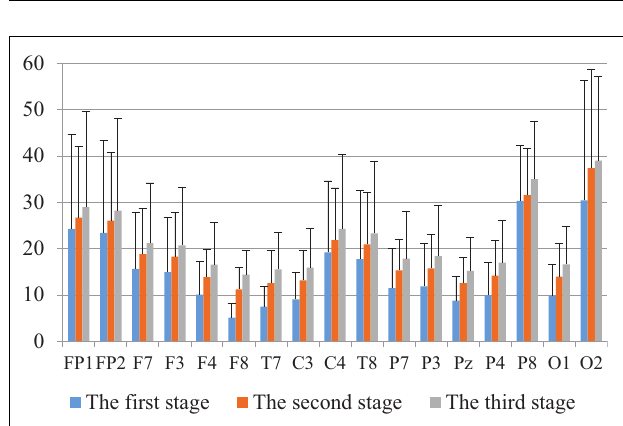
FIGURE 3 | Subject neurofeedback presentation using energy change diagram of left and right frontal lobes.